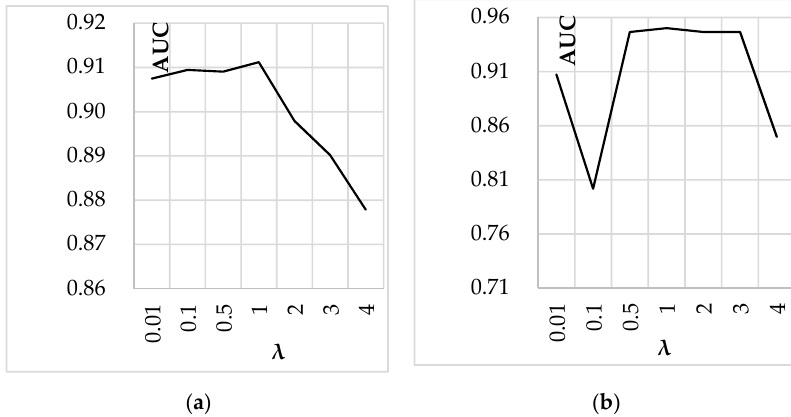
Figure 1. ( a , b ) are the Cross-validation performances that result from applying lasso–logistic-distributed lag regression to the listed manufacturing companies’ data with various values of λ